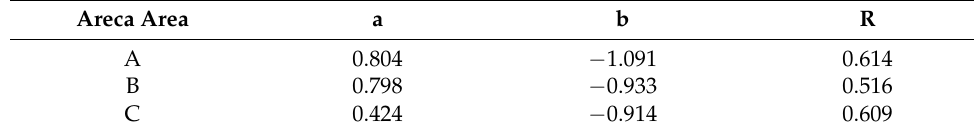
Table 3. Model fitting parameters.